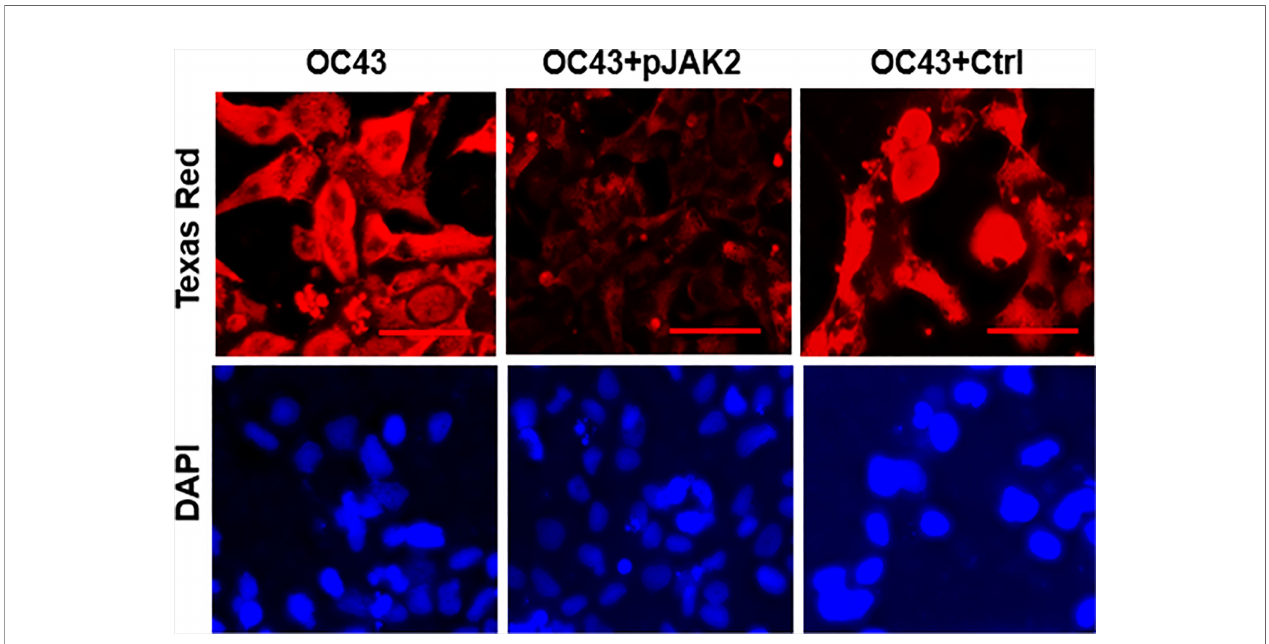
FIGURE 3 | pJAK2 peptide blocks the replication of human coronavirus OC43. RD cells were grown overnight in eight well microscopic slides. They were incubated in low serum medium and treated with pJAK2 or its inactive peptide (both at 30 m M) for 1 hr followed by infection with human CoV OC43 at MOI of 0.1 for 1 hr. The virus was washed, taken in low serum mediun and incubated for 72 hrs. Cells were then fi xed, permeabilized and stained with an antibody to the nucleocapsid protein of HuCoV- OC43. Cells were stained with Texas red conjugated secondary anti-mouse antibody and DAPI, followed by fl uorescence microscopy. The scale bar represents 50